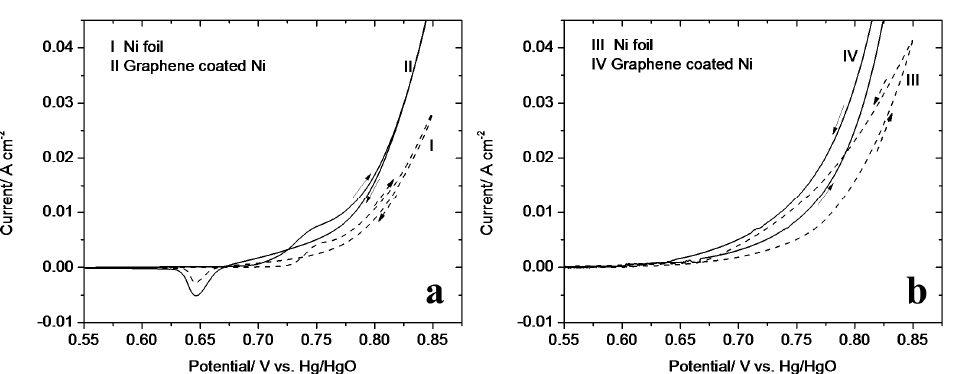
Figure 7. Normalized—by active geometric area of the electrodes—cyclic voltammograms of 2.5 M K 2 CO 3 in the ( a ) absence and ( b ) presence of 5.0 M urea at 70 °C using Ni foil and graphene ‐ coated Ni, at a scan rate of 10 mV s − 1 .